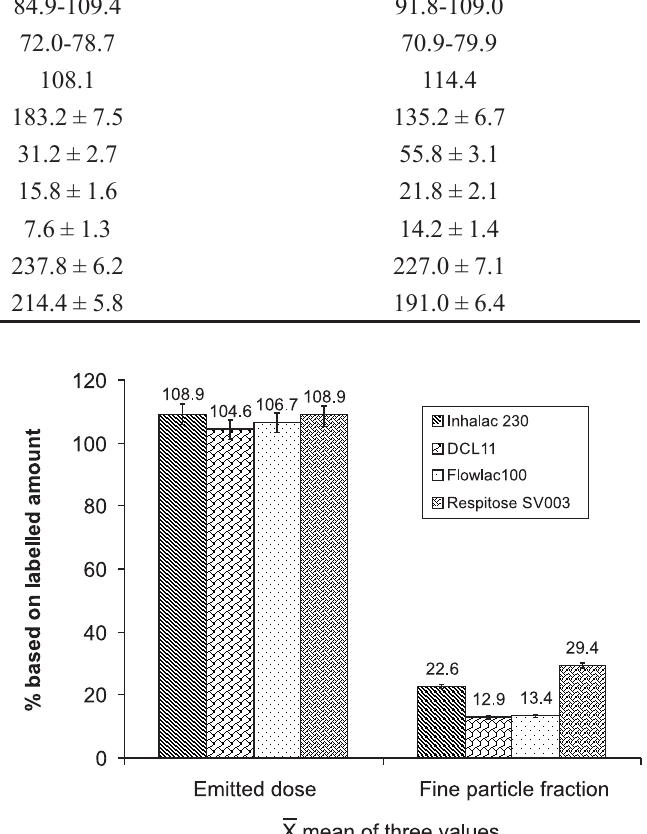
FIGURE 4 - Effect of coarse lactose grade on lactose grade on beclomethasone diprionate DPI